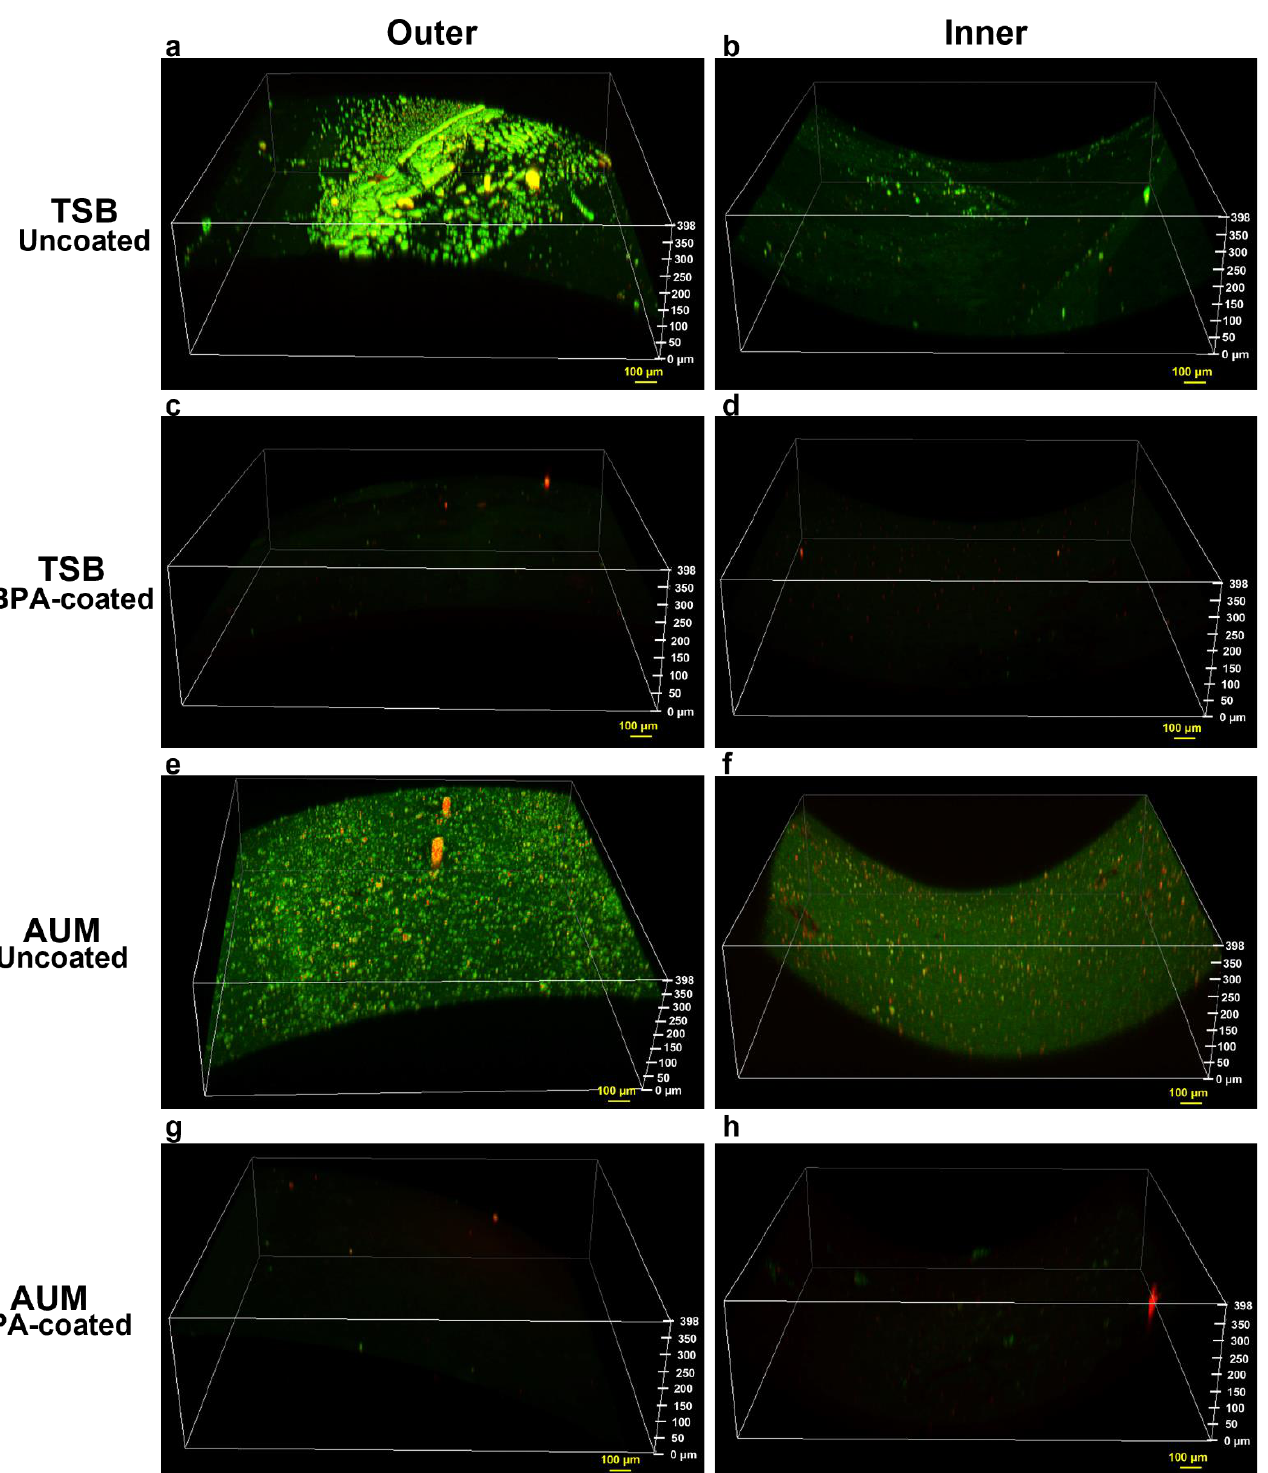
Figure 5. BPA-coating inhibits biofilm formation by UI-033-ESC on the inner and outer surfaces of the coated catheter. Biofilm development was visualized using CSLM following staining with the LIVE/DEAD Bac Light™ Bacterial Viability kit; live bacteria are stained green and dead bacteria are stained red. Outer (a) and inner (b) surfaces of uncoated catheters and outer (c) and inner (d) surfaces of BPA-coated catheters incubated in TSB. Outer (e) and inner (f) surfaces of uncoated catheters and outer (g) and inner (h) surfaces of BPA-coated catheters incubated in AUM. Yellow bars = 100 μm; images are representative of three independent experiments.